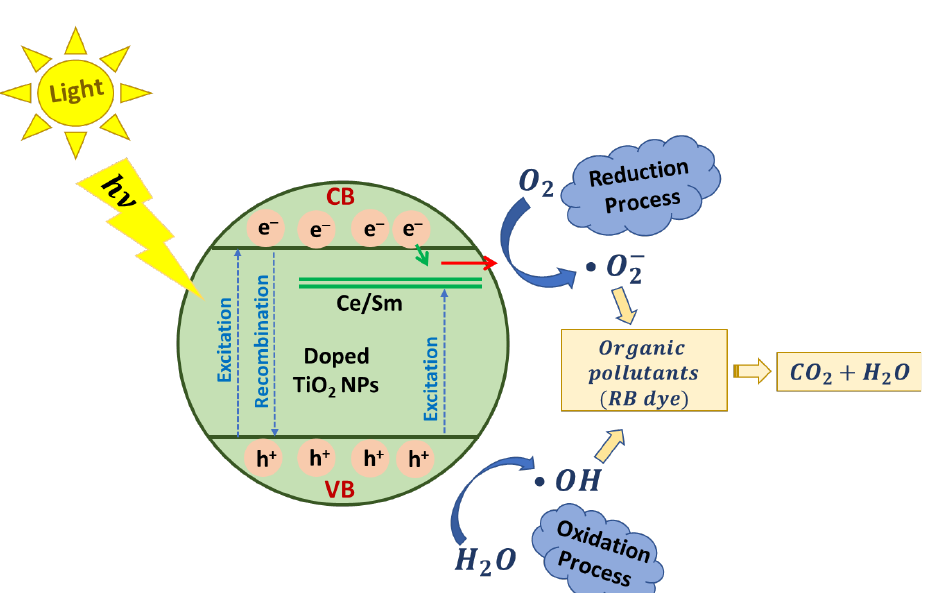
Figure 15. A scheme illustrating the photocatalytic mechanism for Ce–Sm co-doped TiO 2